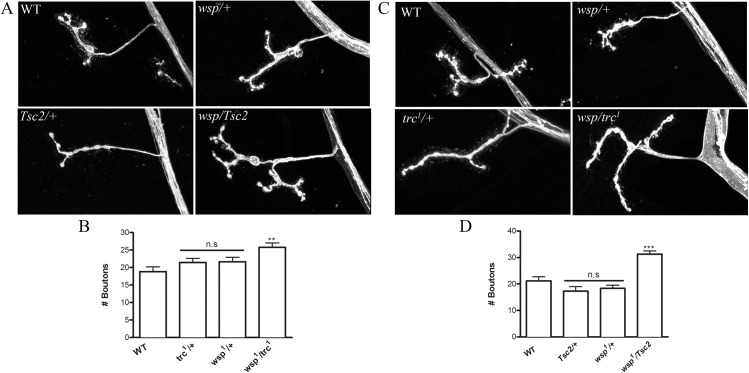

wasp interacts genetically with trc and Tsc2.
A. Representative confocal images of wild type (WT), heterozygotes of wasp (wsp
1/+) stained with anti-HRP antibody. B. Quantification of bouton numbers in genotypes shown in A. C. Representative confocal images of Tsc2 (Tsc2/+), trc
1 (trc
1/+) and transheterozygotes of wasp and Tsc2 (wsp
1/Tsc2) or wasp and trc (wsp
1/trc
1) stained with anti-HRP antibody. D. Quantification of number of synaptic boutons in Tsc2 and wasp heterozygotes (Tsc2/+ or wsp1/+) and their corresponding transheterozygotes (Tsc2/wsp
1). One-way ANOVA followed by Tukey’s post-hoc test was performed. n.s = not significant, **p< 0.01, ***p<0.001. Error bars represent S.E.M.